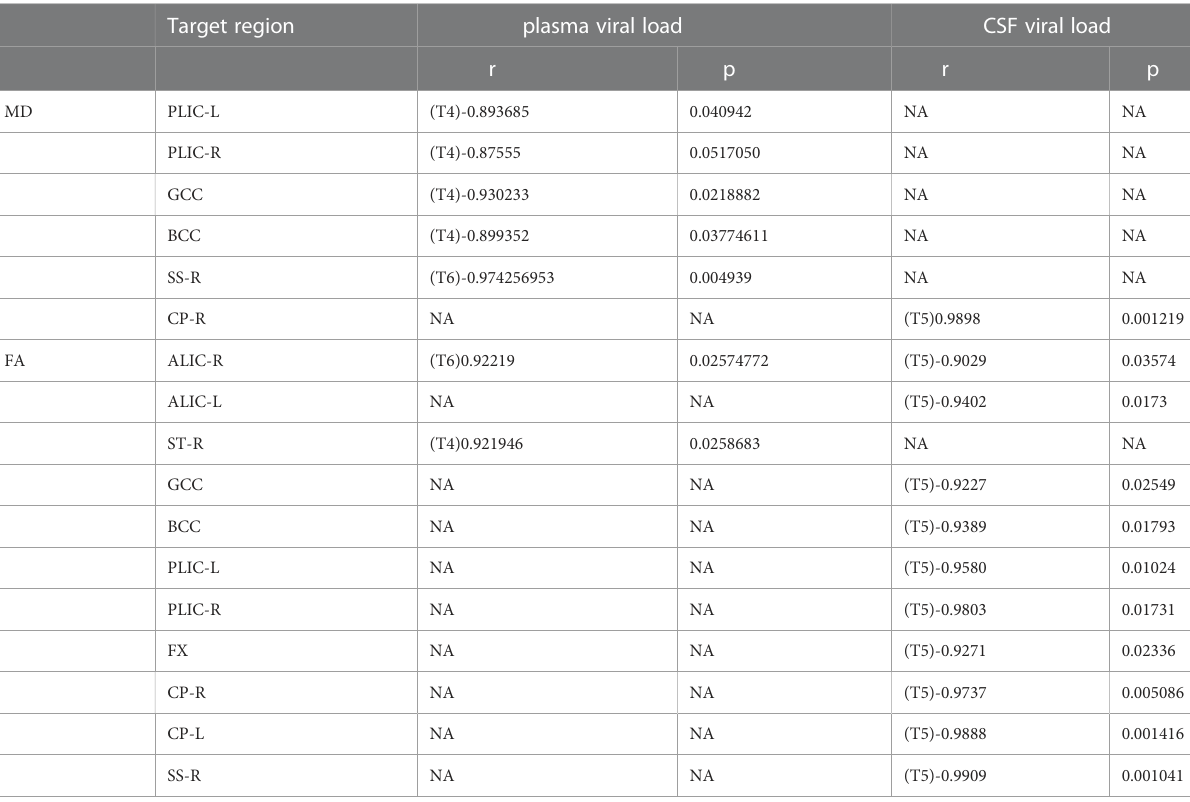
PLIC-R, Posterior Limb of the Internal Capsule – Right; PLIC-L, Posterior Limb ofthe Internal Capsule – Left;GCC, Genu of Corpus Callosum; BCC, Body ofCorpus Callosum; SS-R, SagittalStriatum-Right;ALIC-R,AnteriorLimboftheInternalCapsule – Right;ALIC-L,AnteriorLimboftheInternalCapsule – Right;ST-R,StriaTerminalus – Right;FX,Fonix;CP- R, Cerebral Peduncle - Right; CP-L, Cerebral Peduncle - Left. T4 means time point 4 (that is 12 weeks post inoculation); T5 means time point 5 (that is 24 weeks post